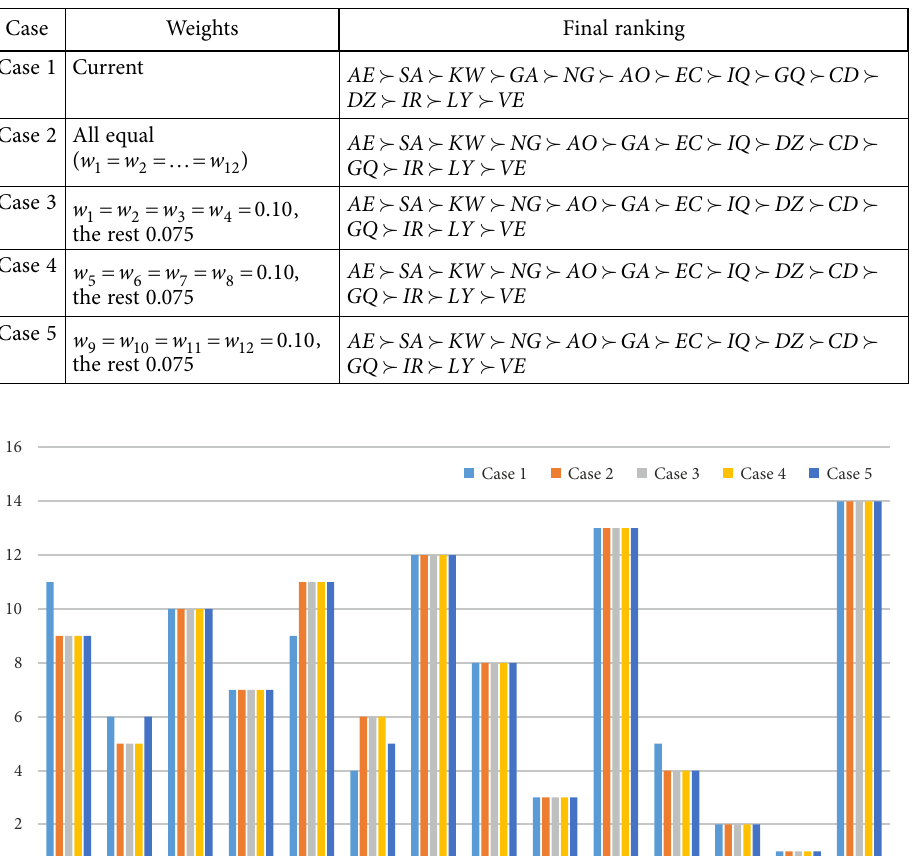
Table 8. The ranking order of alternatives concerning the changes of criteria weights